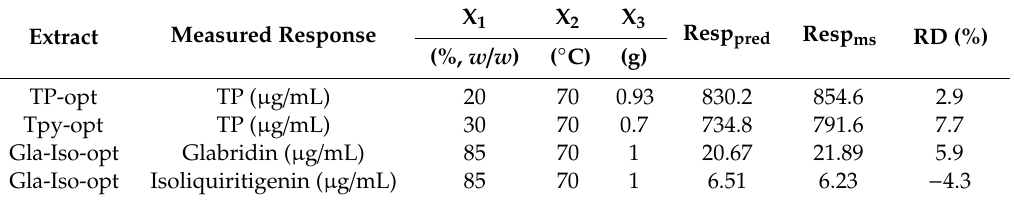
Table 5. Predicted and observed values for the optimized